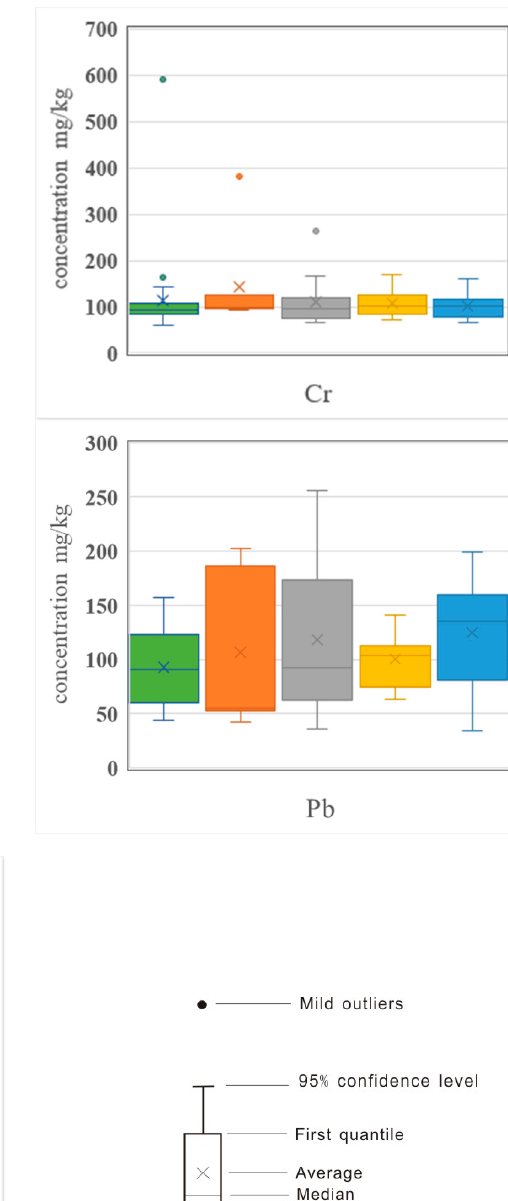
Figure 1. Map of sampling points in Shijiazhuang City. Green, yellow, red, purple, and blue triangles represent residential, commercial, industrial, office, and traffic areas, respectively.